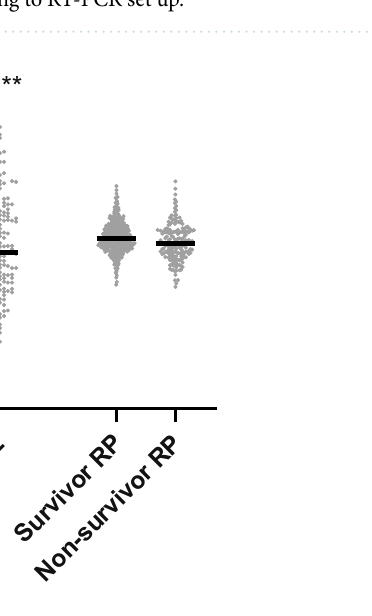
Figure 2. Scatter plots of Ct value distributions by age groups for E, N2, and RP assay. Solid horizontal short lines represent median Ct values for designated age groups. Patients ≥ 80 years old had lowest median Ct values for both virus detection assays (E and N2), compared to other adult age groups (table underneath the plots). Ct values from the quality control assay (RP) were very similar among different groups, suggesting overall good laboratory practice from sample processing to RT-PCR set up.